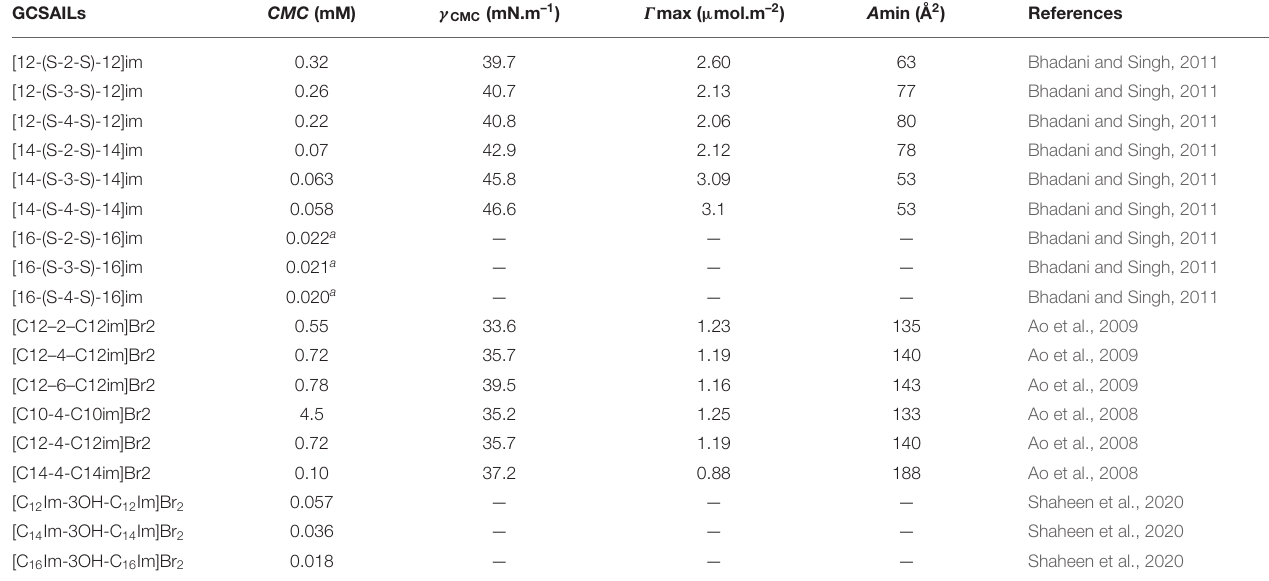
TABLE 3 | Reported values of critical micelle concentration (CMC), the surface tension at CMC ( γ CMC), surface excess concentration ( Γ max), and minimum area per molecule at air–water interface ( A min) for Gemini cationic surface-active ionic liquids (GCSAILs) at 298.15K in aqueous medium. GCSAILs